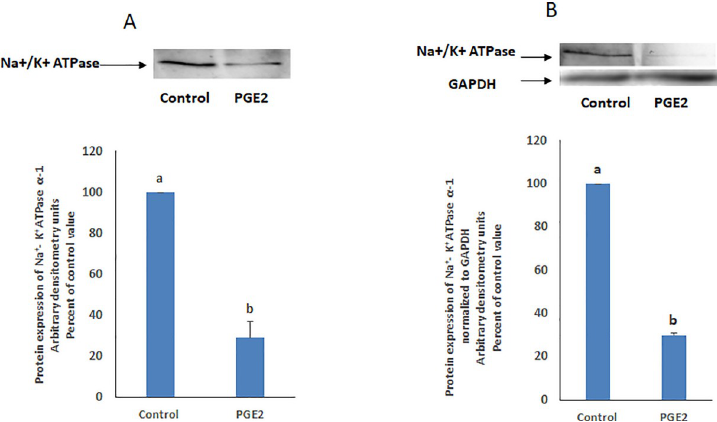
Fig 7. PGE2 reduces the protein expression of the Na + /K + ATPase. Cells treated with PGE2(1 nM, 20 min) were collected and fractionated by differential centrifugation to isolate plasma membranes. Eight microgram samples from the cell homogenate (A) and from the membrane fraction (B) were used for western blot analysis. PGE2 reduced significantly the expression of the ATPase as indicated by the student t test (P < 0.01). The blots are representative of an experiment repeated three